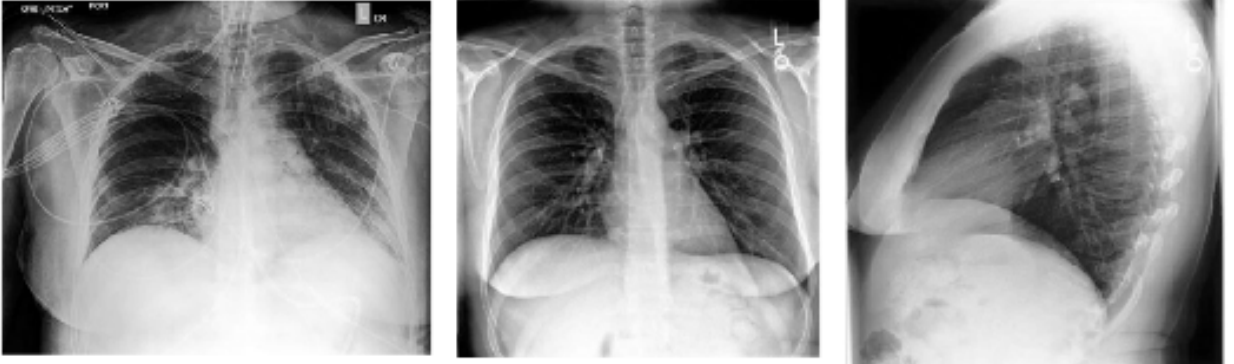
Figure 5. Left : Anterior–posterior (AP) view chest X-ray. Middle . Posterior–anterior (PA) view frontal chest X-ray. Right : lateral chest X-ray.